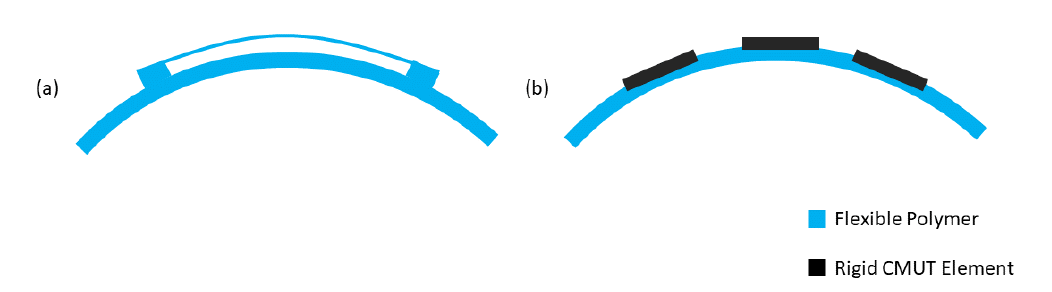
Figure 10. Approaches to fabricating flexible CMUTs. ( a ) CMUT fabricated from entirely flexible polymers. ( b ) Isolated rigid CMUTs embedded within a flexible